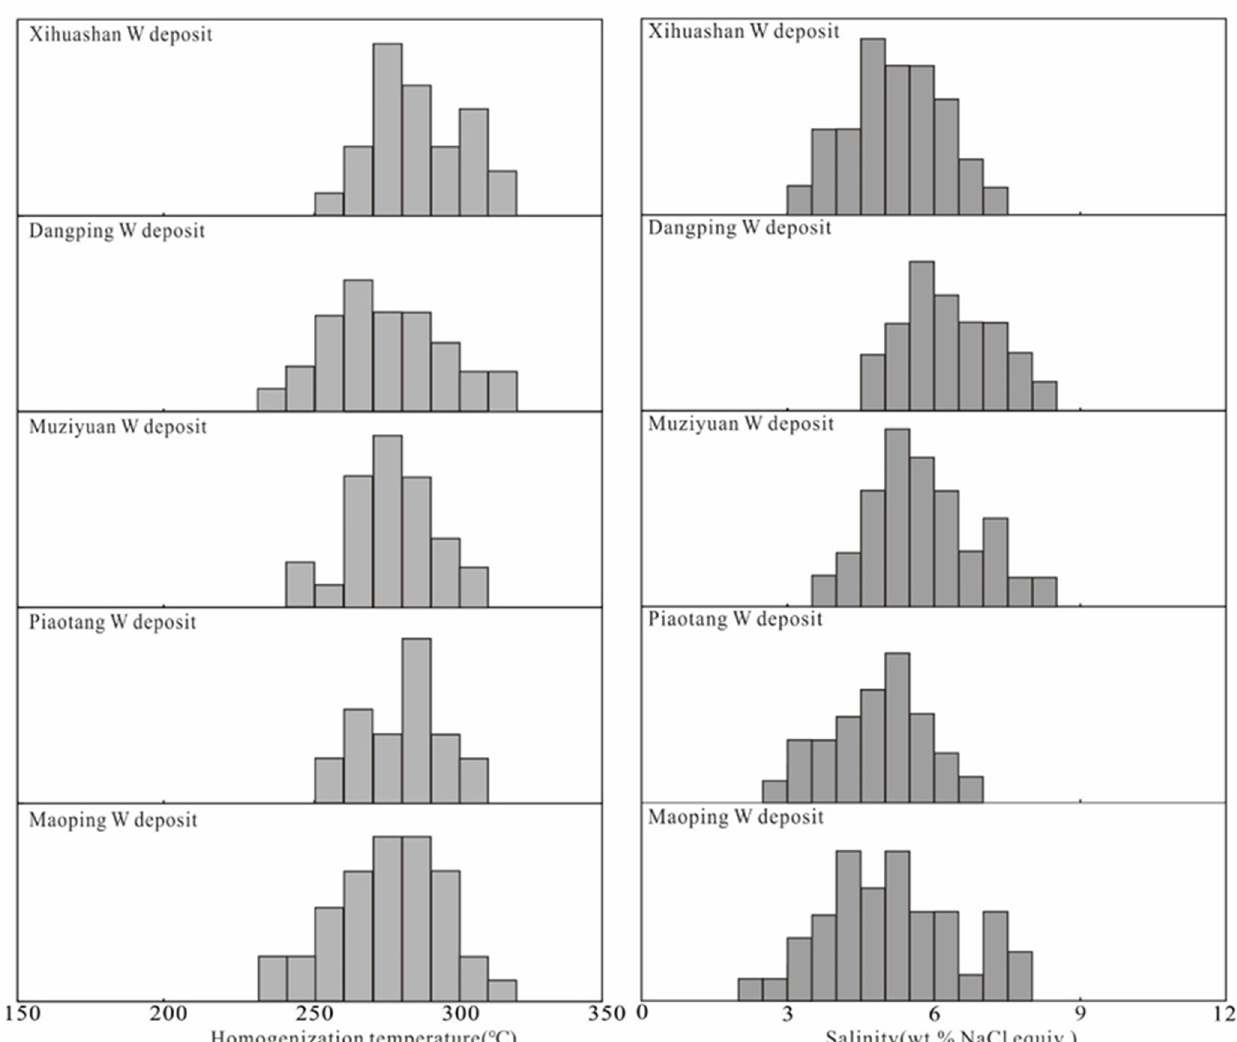
Figure 12. Histograms of homogenization temperatures ( T h ) and salinities for fluid inclusions from the different tungsten deposits in the Xihuashan-Zhangtiantang region.